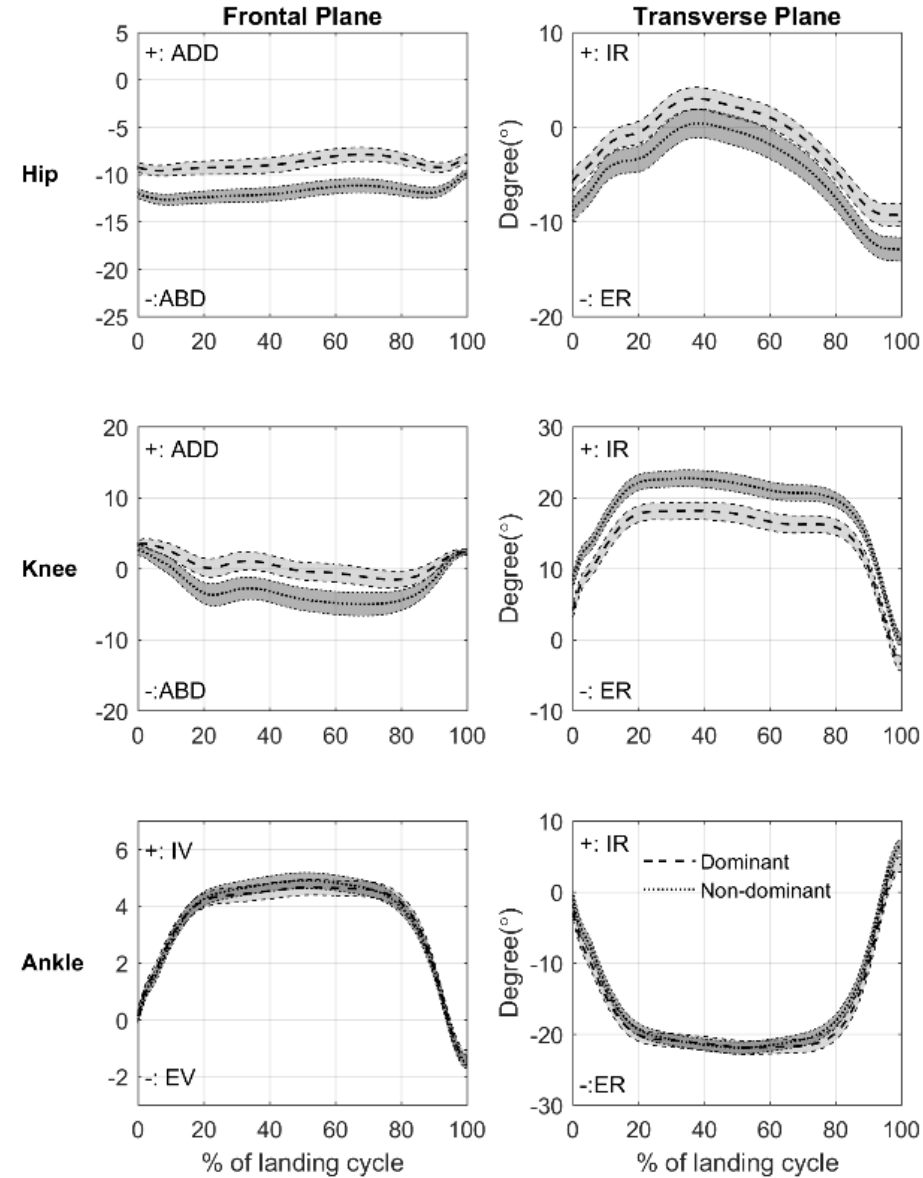
Figure 3. Bilateral differences in the hip and knee joint angle patterns in frontal and transverse planes from initial contact to toe-off (0–100% of landing cycle) during the stance phase of drop vertical jump. The dashed line with light grey area represents the mean ± 95% CI for dominant limb, and the dotted line with dark gray area indicates the mean ± 95% CI for non-dominant limb. The positive values present hip and knee adduction (ADD), ankle inversion (IV), and hip, knee, and ankle internal rotation (IR), and the negative values present hip and knee abduction (ABD), ankle eversion (EV), and hip, knee, and ankle external rotation